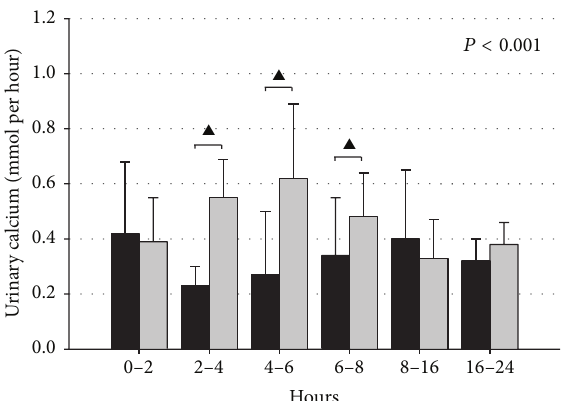
Figure 3: Diurnal variations in renal excretion of calcium (excretion per hour) in patients with hypoparathyroidism following 24 weeks of (black) ( 𝑛 = 21 ) or placebo (gray) ( 𝑛 = 17 ). 𝑃 value indicates significance between group differences by treatment with 100 𝜇 g of PTH 1 – 84 repeated measurements ANOVA. 󳵳 𝑃 < 0.01 by post hoc comparison. Reproduced with permission from JBMR